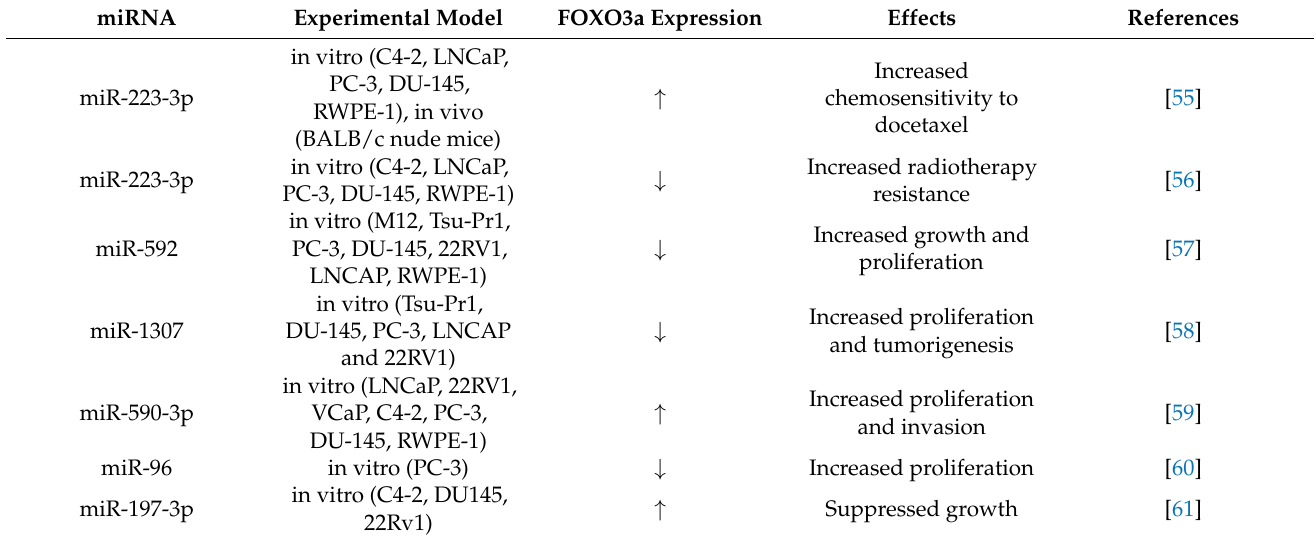
Table 2. Summarized information about miRNA and their influence on FOXO3 expression and the effect in cells. miRNA Experimental Model FOXO3a Expression